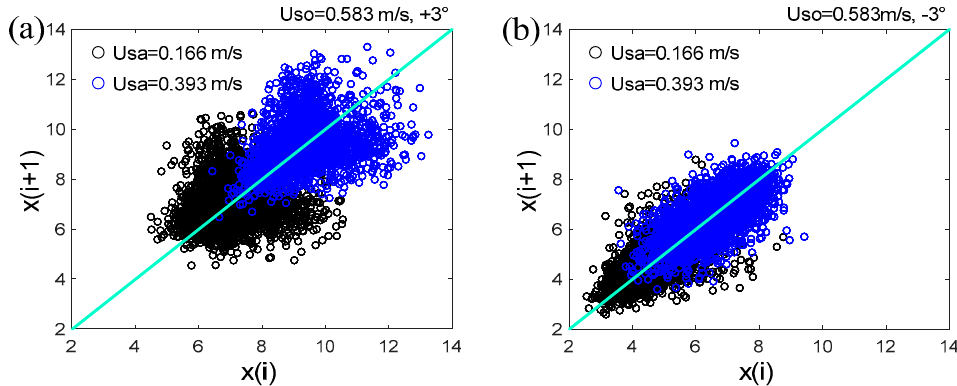
Figure 18. Poincaré plot of the probe signals collected from typical flow conditions: ( a ) Uso = 0.584 ◦ ; ( b ) Uso = 0.584 m / s, − 3 ◦ m/s, +3°; ( b ) Uso = 0.584 m/s, − 3°. + 3